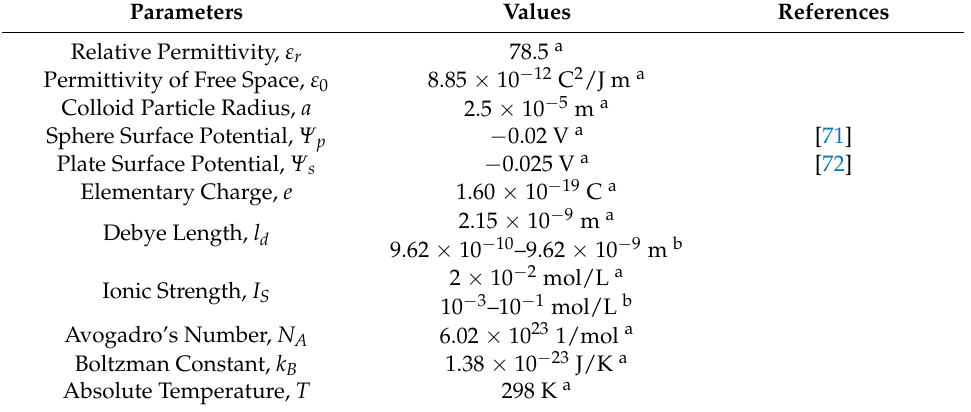
Table 1. Parameter values of electrostatic interaction employed in the theoretical considerations.